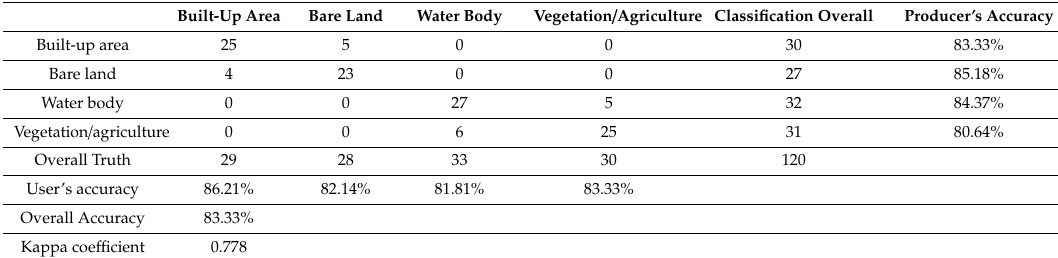
Table A2. Confusion matrix of the 2019 LULC map of